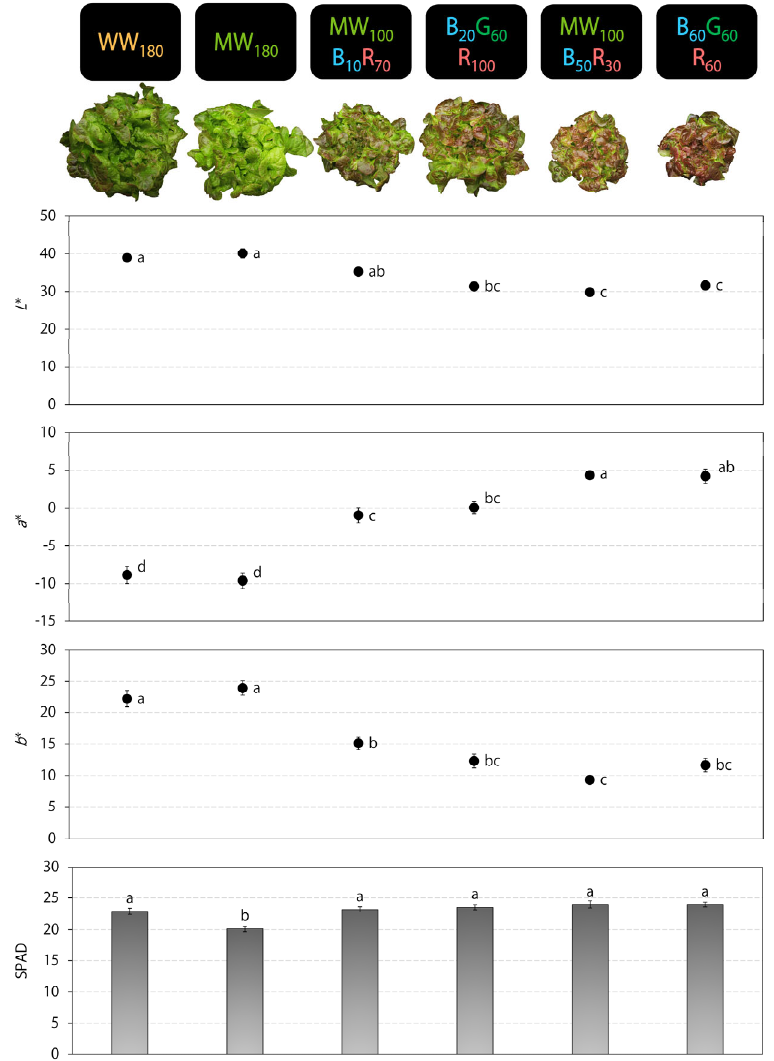
Figure 2. Leaf color indices ( L * a * b *) and relative chlorophyll index (SPAD value) of red-leaf lettuce ‘Rouxai’ grown under six indoor lighting treatments delivered by warm-white (WW), mint-white (MW), blue (B), green (G), and/or red (R) light-emitting diodes (LEDs) ( n = 20). The number after each LED type is its photon flux density in µ mol · m − 2 · s − 1 . For each parameter, values followed by different letters are statistically different ( α =